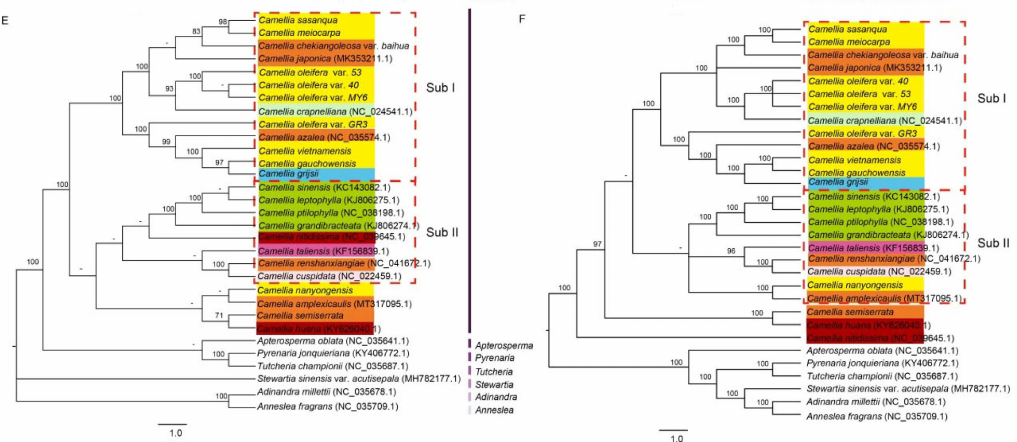
Figure 8. Phylogenetic trees of Camellia species and closely related genera in the family Theaceae. ( A , B ) Phylogenetic trees constructed using complete cp genome data with maximum likelihood and Bayesian analysis methods, respectively. ( C , D ) Phylogenetic trees constructed using the coding region data with maximum likelihood and Bayesian analysis methods, respectively. ( E , F ), Phylogenetic trees constructed using the noncoding region data with maximum likelihood and Bayesian analysis methods, respectively. Seven genera in Theaceae family are highlighted with vertical bars in different colors and eight sections in Camellia are marked with rectangles in different colors on the cladogram. The subclade I and II are marked with red dotted boxes. Numbers next to the branches correspond to maximum likelihood bootstrap support and Bayesian posterior probability values, respectively. The hyphen refers to the bootstrap or posterior probability values of